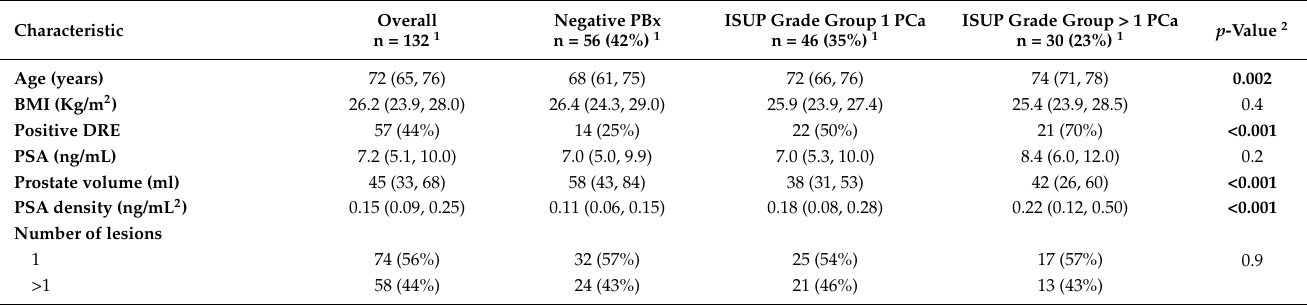
Table 1. Descriptive statistics of 132 patients who underwent prostate biopsy (PBx) for suspicion of clinical prostate cancer (PCa) with available multiparametric-magnetic resonance imaging (mp-MRI)